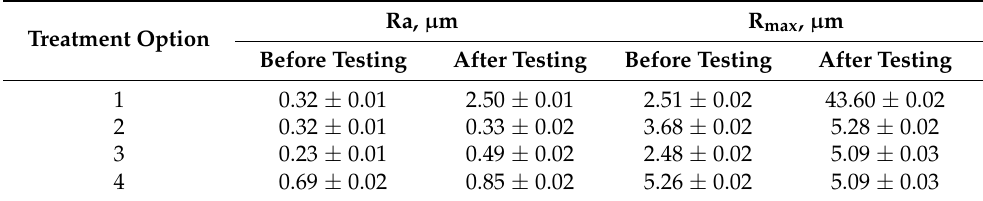
Figure 12. Surface defects (600 × ) in the area of the contact patch, characteristic of wear during fretting with treatment options 1 ( a ), 2 ( b ), 3 ( c ), and 4 ( d ). Table 1. Results of the surface roughness study.